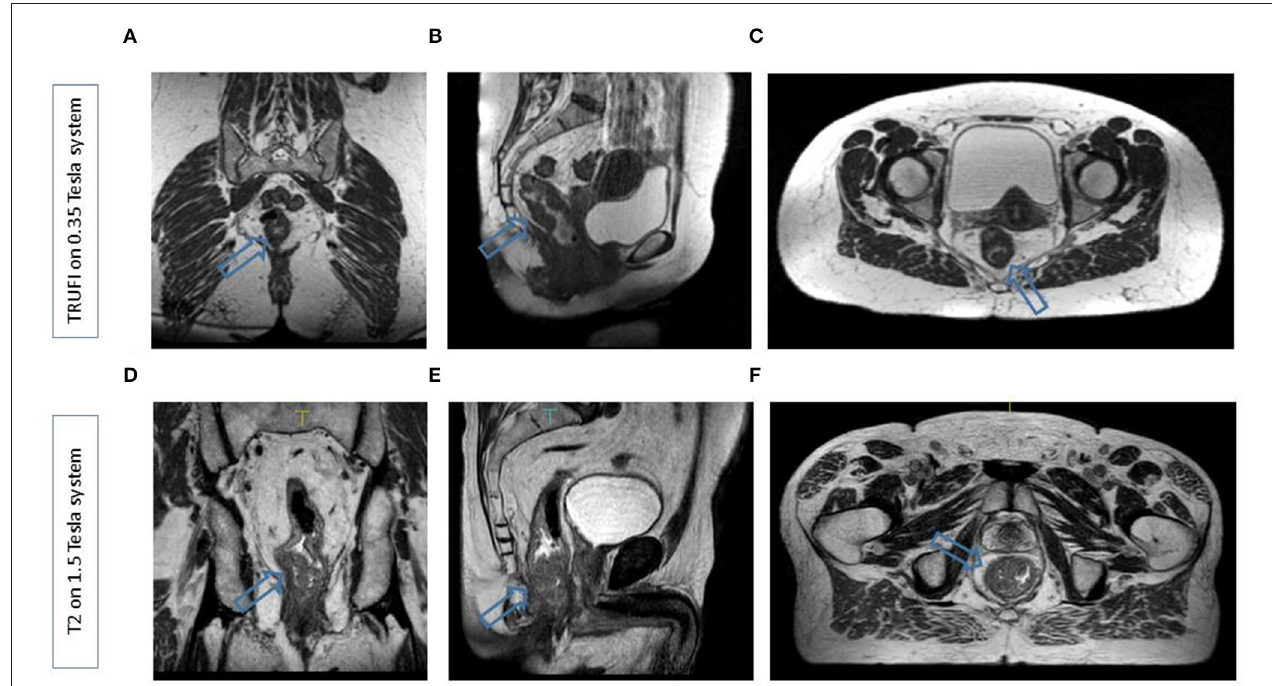
FIGURE 1 | Representative scans from the 0.35T MR LINAC (A–C) in the coronal, sagittal, and transverse planes and the 1.5T MR LINAC (D–F) in the coronal, sagittal, and transverse planes. In both cases, a patient with a distally located rectal tumur was scanned. Arrows indicate the